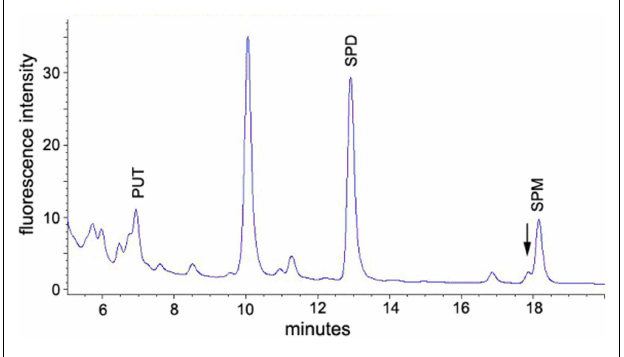
FIGUREA1 | A. thaliana stem extract derivatized with FMOC-Cl. The pattern of elution is identical to the flower bud extract ( Figure 2 ).The large unmarked peak is an derivatization artifact. Put, putrescine; spd, spermidine; spm, spermine.Thermospermine most likely elutes as a left shoulder of spermidine. Notice the different scale compared to Figure 2